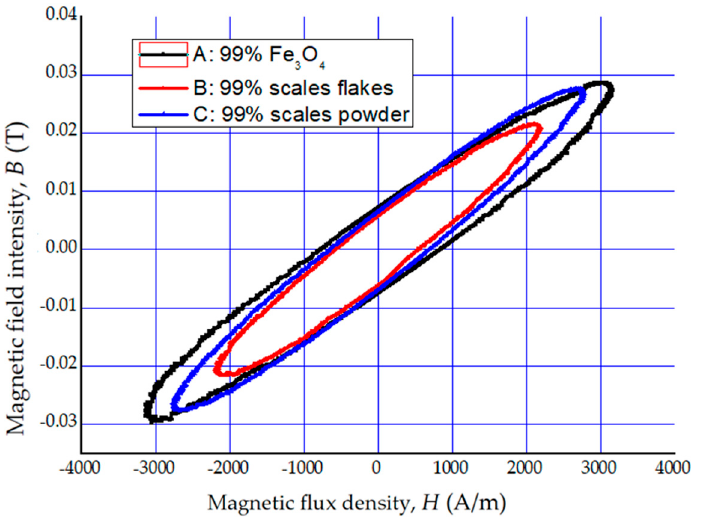
Figure 11. Hysteresis loop for composite (A): 99% pure Fe 3 O 4 and 1% HDPE matrix, B max = 0,029 T, H max = 3150 A/m, µ r = 7,4, @ 50 Hz. (B): 99% scales flakes and 1% HDPE matrix, B max = 0,028 T, H max = 2778 A/m, µ r = 7,9, @ 50 Hz. (C): 99% scales powder and 1% HDPE matrix, B max = 0,021 T, H max = 2195 A/m, µ r = 7,8, @ 50 Hz.